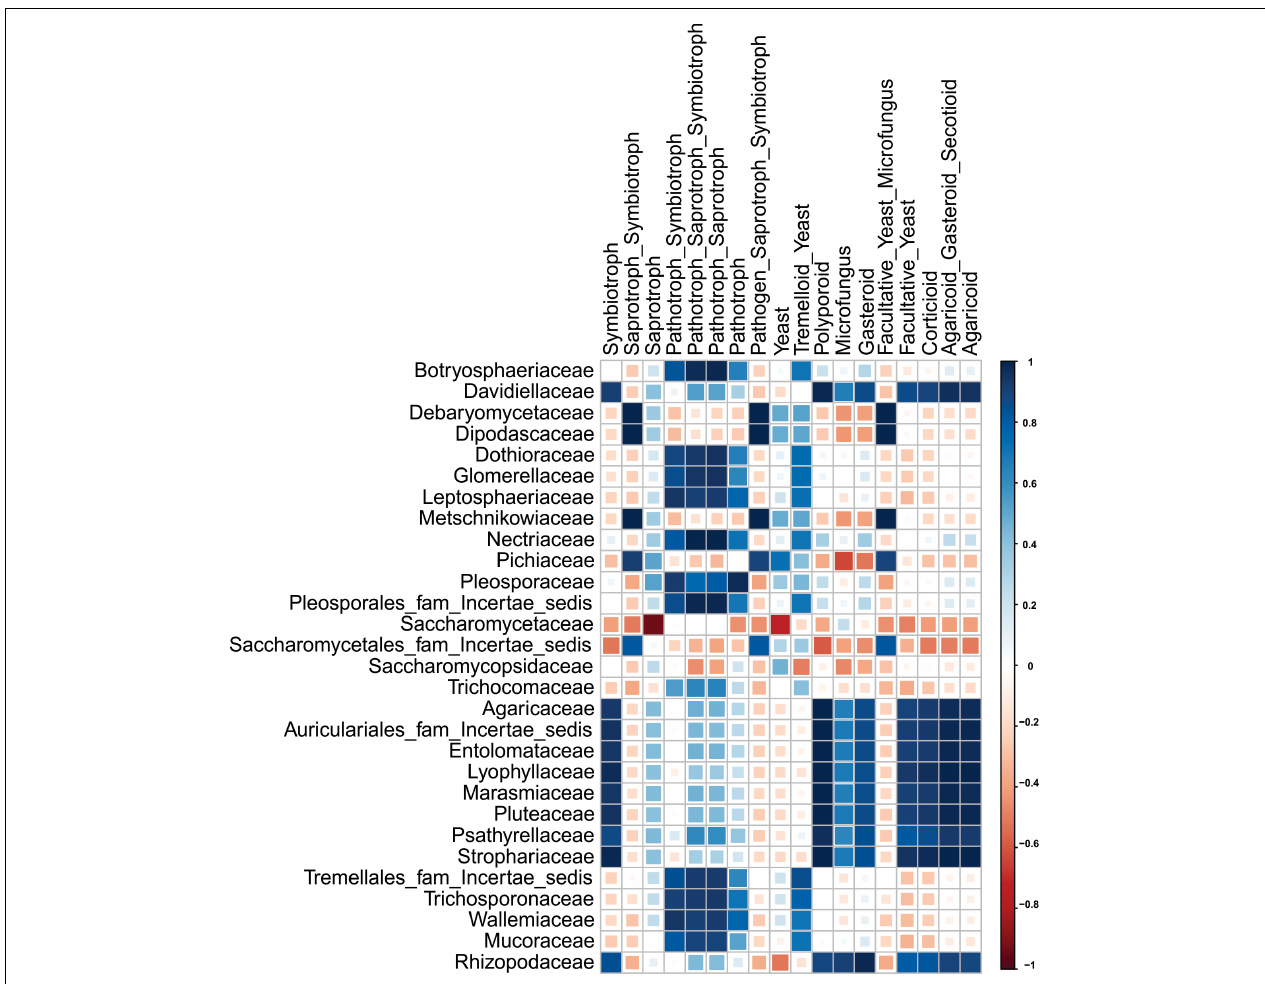
FIGURE 5 | Plot showing the spearman correlation values for family level diversity having > 1.0% abundance in each sample and different features of